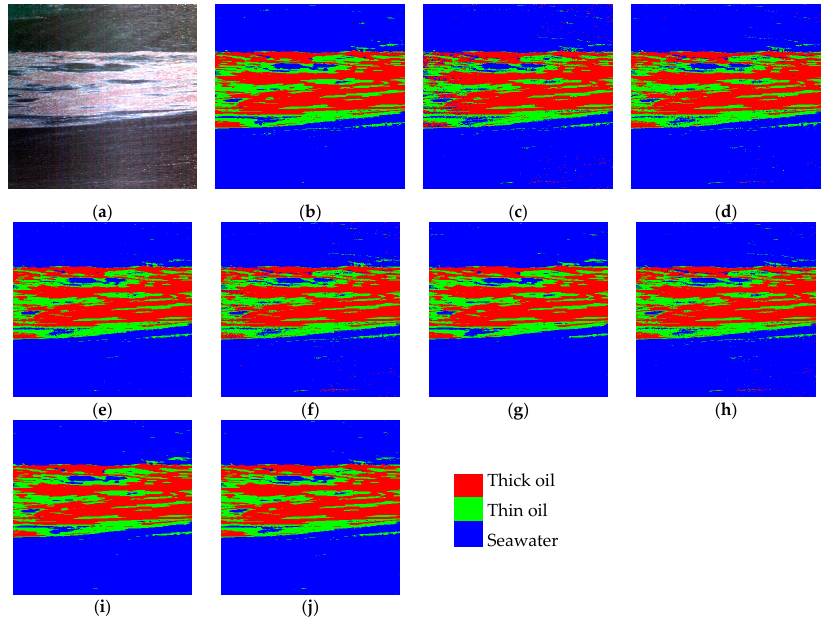
Figure 6. Hyperspectral oil spill detection results of dataset 1. ( a ) False-color image. ( b ) Ground truth. ( c ) RF. ( d ) SVM HSI . ( e ) SVM HSI&GLCM . ( f ) NN. ( g ) LetNet-5. ( h ) SPE-CNN. ( i ) SPA-CNN. ( j ) SSFIN.